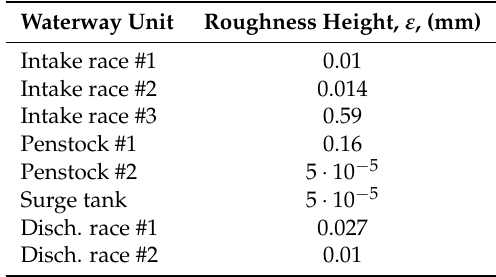
Table 4. The waterway parameters tuned with the least squares error method.